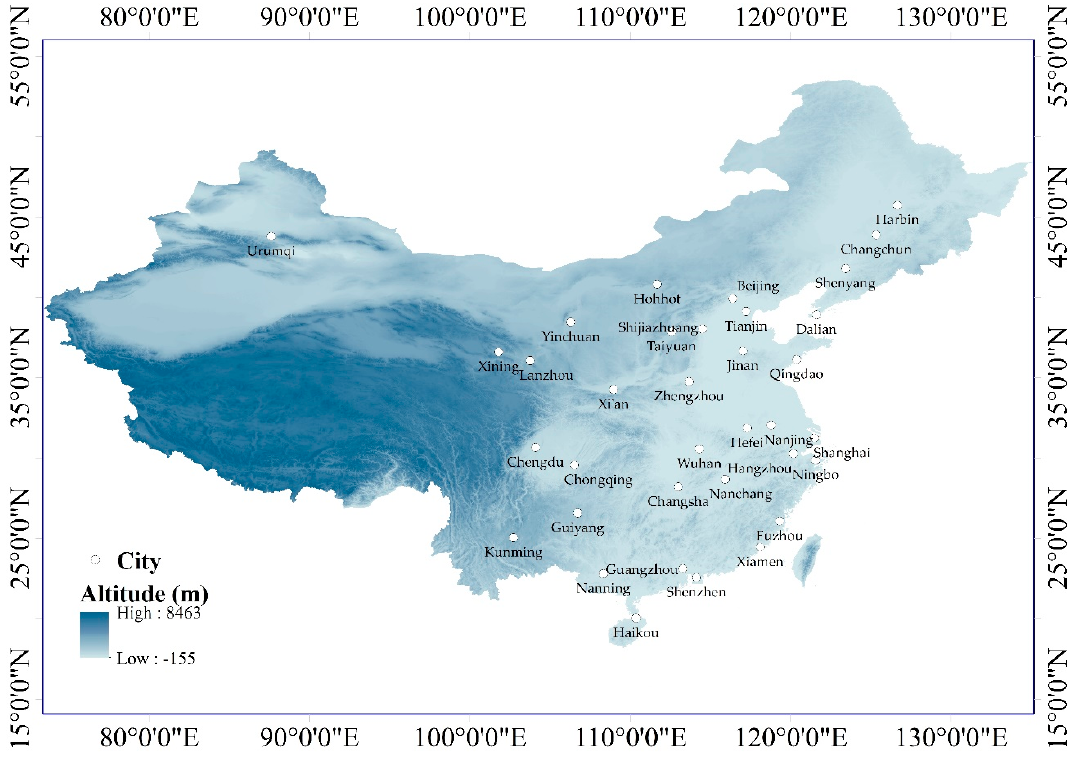
Figure 1. Locations of the 35 cities selected as study areas.